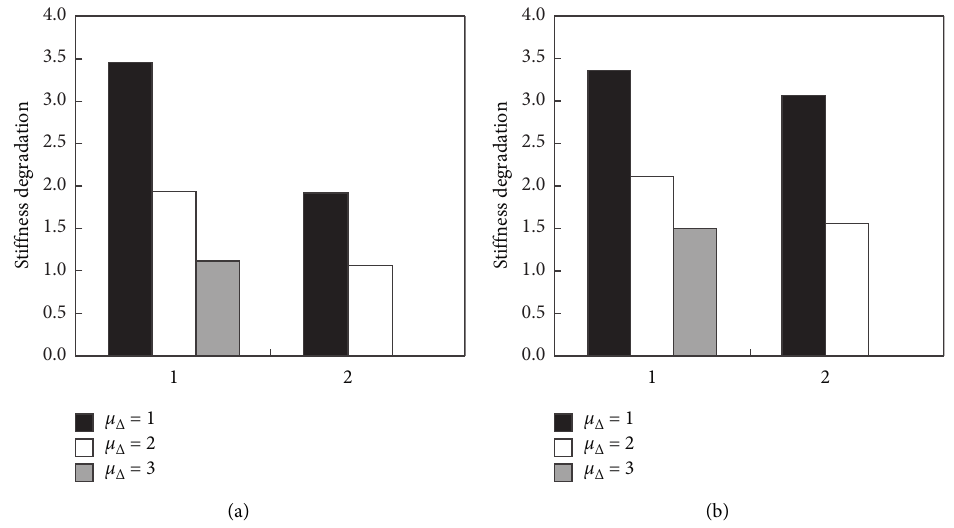
Figure 13: Stiffness comparison of joints (analysis results): (a) before reinforcement; (b) after